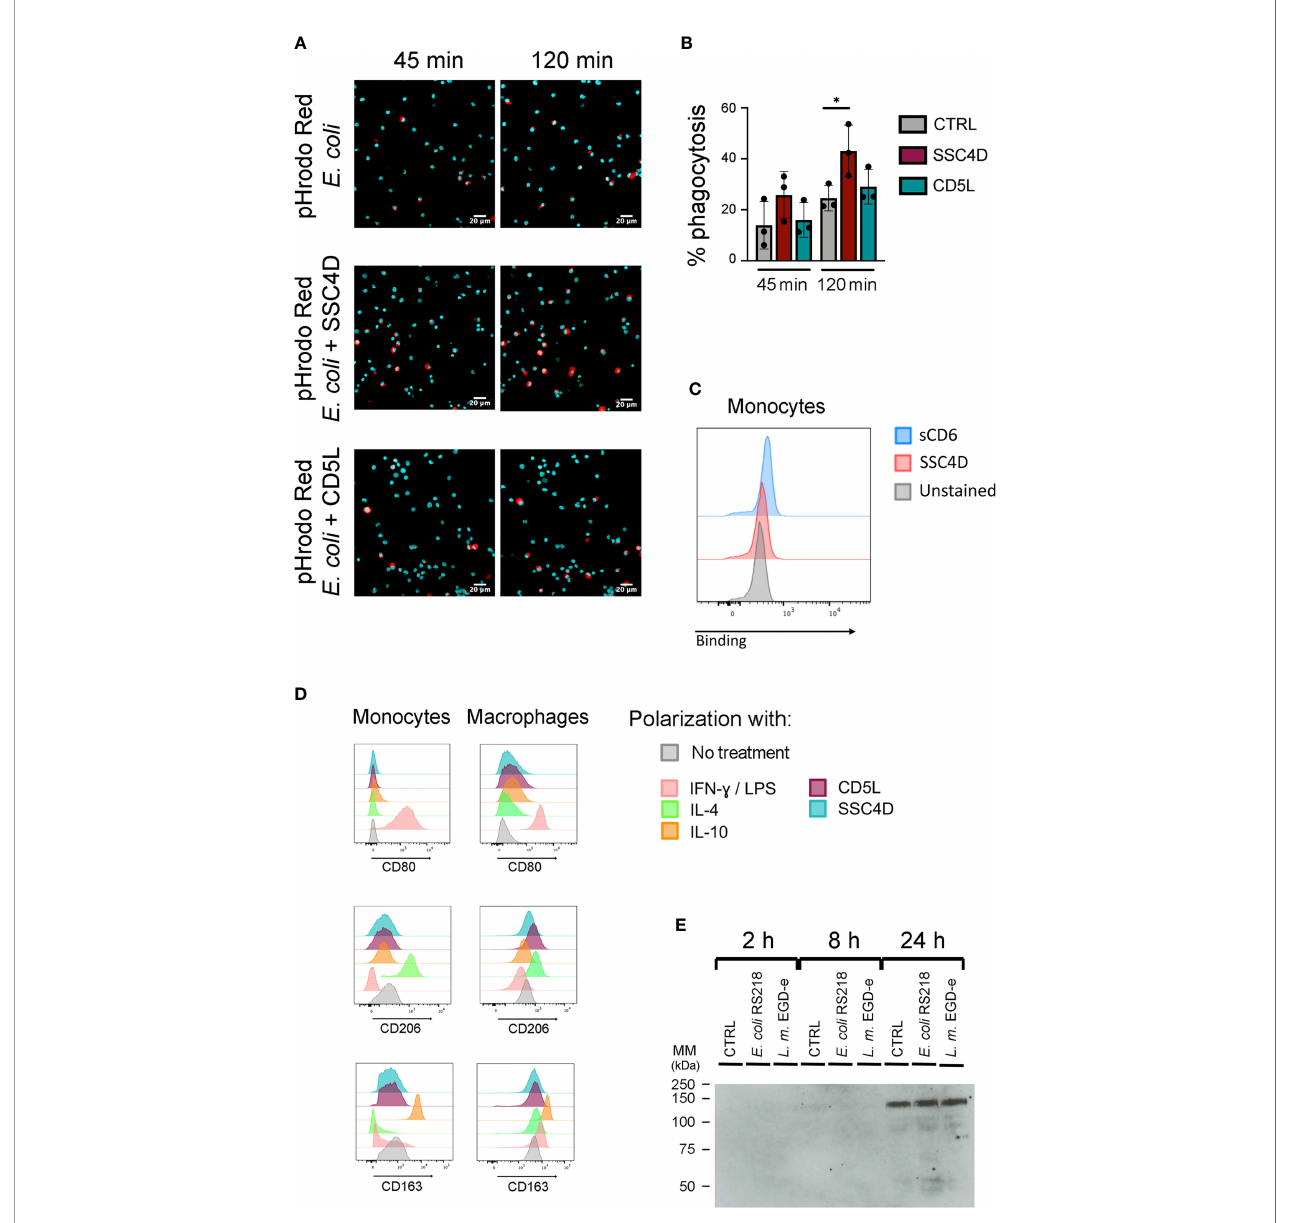
FIGURE 5 | SSC4D promotes phagocytosis without binding to a ligand on human monocytes and does not induce macrophage polarization. (A) Escherichia coli pHrodo BioParticles (40 m g/ml) were added to isolated human monocytes, together with 5 m g/ml of SSC4D (middle panels) or CD5L (bottom panels), or no protein (top panels). Images were acquired for each well at 45 and 120 min after the addition of E. coli BioParticles using an IN Cell Analyzer, followed by analysis using FIJI software. Blue indicates DAPI staining, and red indicates phagocytosed E. coli BioParticles. (B) The percentage of monocytes containing E. coli BioParticles was quanti fi ed. Graph shows the mean ± SD of three independent experiments performed in duplicate. Statistical analysis was performed using Student ’ s t test. *p < 0.05. (C) Ex vivo monocytes were incubated with 3 m g of SSC4D or sCD6 or left unstained. Cell-bound proteins were detected with anti-HIS antibody followed with Alexa Fluor 647-conjugated anti-mouse antibody and analyzed by fl ow cytometry. Gray histograms represent control cells, not stained with scavenger receptor cysteine-rich (SRCR) protein but incubated with secondary antibody, red histograms represent labeling with SSC4D, and blue histograms represent labeling with sCD6. (D) Flow cytometry analysis of ex vivo monocytes (left column) and macrophage colony-stimulating factor (M-CSF)-differentiated macrophages (right column). Monocytes received for 72 h the appropriate stimuli to polarize toward M1 [interferon (IFN)- g /lipopolysaccharide (LPS)], M2a [interleukin (IL)-4], or M2C (IL-10) subtypes. Macrophages received the same treatment, but for 24 h. CD80, CD206, and CD163 labeling con fi rms the polarization of monocytes and macrophages into the correct subtype. Stimulations with SSC4D or CD5L had no effect on cell polarization except for a slight effect of CD5L in polarizing macrophages into an M2a-like phenotype. Representative histograms are from one of three independent experiments. (E) SSC4D secretion upon culture infection with live bacteria. Caco- 2 cells were engineered to express SSC4D fused to citrine and were cultured for 3 days at 3 × 10 5 cells/well in a 12-well plate. Live E . coli RS218 or L. monocytogenes EGD-e were added at 1:50 multiplicity of infection (MOI). Supernatants were collected at the indicated time points, and the presence of HA-tagged SSC4D-citrine was detected by western blotting. The blot shown is representative of two independent